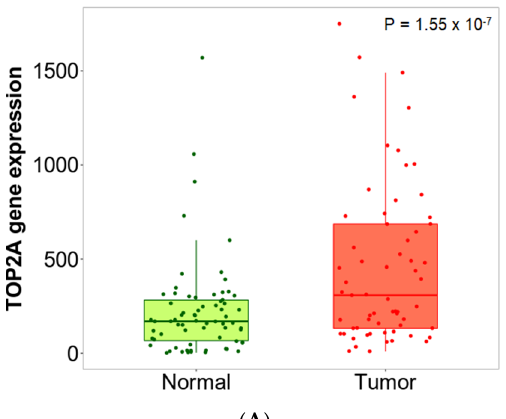
Figure 1. Boxplots of top two genes differentially expressed in most of the ten common tumor types. Significant differences by a Mann–Whitney U test are marked with red color (* p < 0.01).